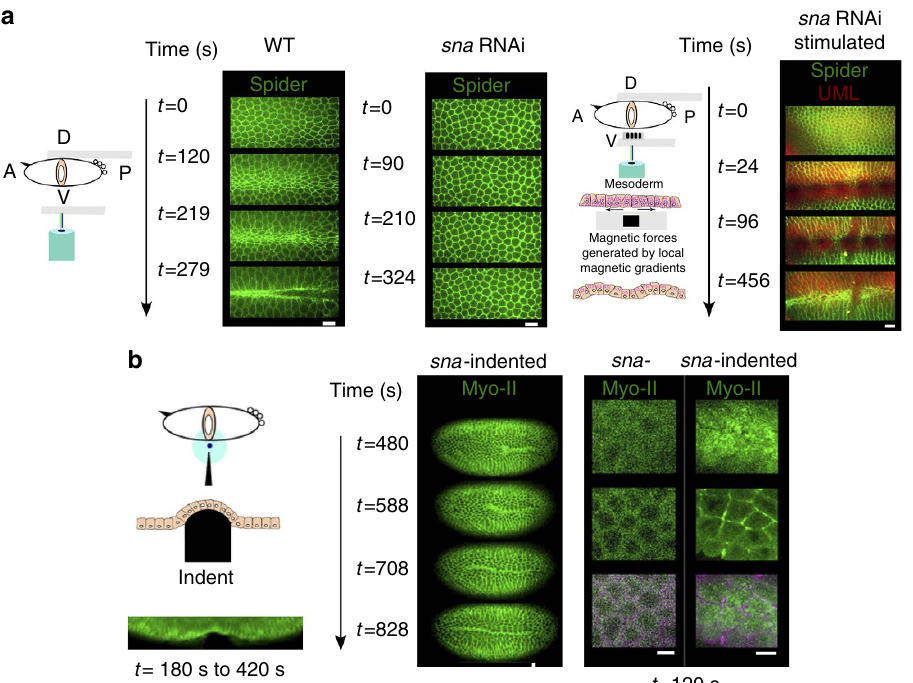
Figure 4 | Rescue of mesoderm invagination in sna -defective embryos by mechanical pulses. ( a ) Coordinated apical constrictions in Spider–GFP followed by mesoderm invagination in the WT, all of which are impaired in sna RNAi-injected embryos ( n ¼ 6 on N ¼ 6 injected), are rescued (constrictions initiating at 96s and mesoderm invagination at 456s) after the initiation of magnetic stimulation of sna -dependent pulsations in sna RNAi-injected embryos (UML in red). Representative of n ¼ 8 of the N ¼ 13 embryos observed (full invagination ( n ¼ 5), partial invagination ( n ¼ 3), P o 10 (cid:2) 3 , exact Fisher test, considering the N ¼ 12 sna RNAi-injected embryos of Figs 1e and 4a that do not invaginate). The shadow line is a vitelline membrane folding independent of the process. ( b ) Mechanical rescue and propagation along the mesoderm of apical stabilization of Myo-II and mesoderm folding in sna mutant embryos by local indent: sna-Myo-II-GFP embryo indented 3min after the end of ventral cellularization, and 4min before the movie initiation and rotated 90 (cid:2) . Representative of n ¼ 19 of the N ¼ 22 embryos observed (10 total invaginations, 9 partial invaginations, P o 10 (cid:2) 3 , exact Fisher test considering that none of the sna mutants invaginate). Zoom on the mesoderm of the indented sna-Myo-II-GFP embryo. Representative of n ¼ 4 of the N ¼ 4 embryos observed in each case ( P o 10 (cid:2) 3 , exact Fisher test, with 3 total invaginations, 1 partial invagination). Observations are realized with a (cid:3) 20 objective. Scale bar, 5 m